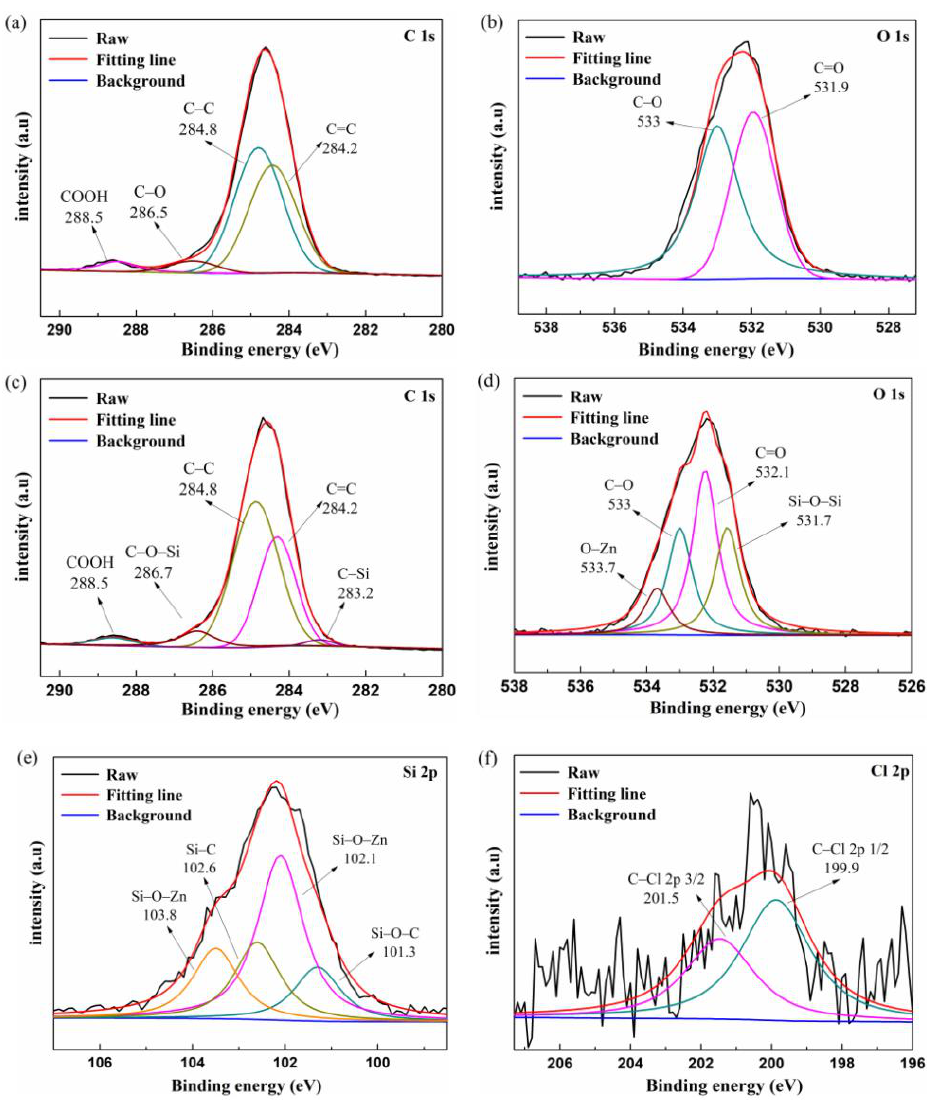
Figure 3. XPS spectra of CGC ( a ): C 1s and ( b ): O 2s and CPTES/CGC ( c ): C 1s, ( d ): O 2s, ( e ): Si 2p, and ( f ): Cl 2p.